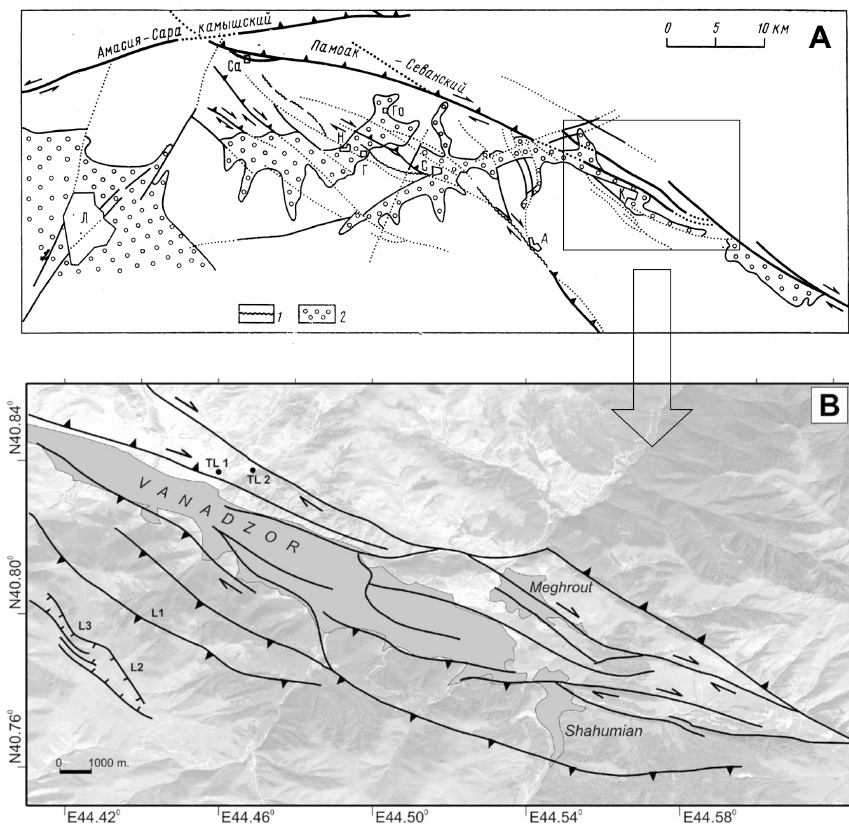
Figure 5. Sources for mapping the Pambak–Sevan fault near Vanadzor city, Armenia. Panel (a) displays an initial study by Trifonov et al. (1990), where geographical objects and coordinates had been omitted due to Soviet legal requirements; the location of Vanadzor is labeled with “K” (representing its former name “Kirovakan”) within the box. Panel (b) shows a more recent georeferenced map (Karakhanian et al., 2004). Both papers affected the location and attributes of the Pambak–Sevan fault in AFEAD, including the object highlighted in Fig. 2.